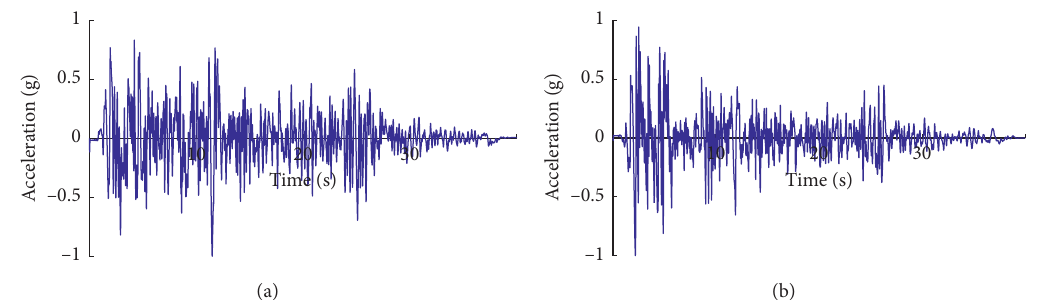
Figure 10: Acceleration time history curve of El Centro seismic wave. (a) X direction. (b) Y